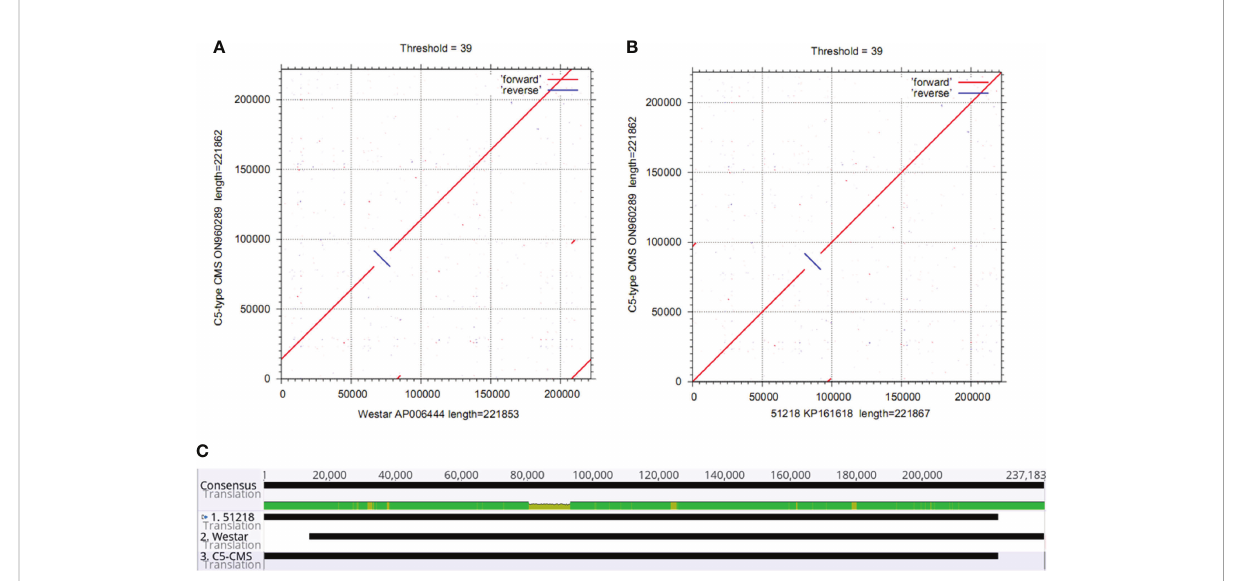
FIGURE 5 Comparative analysis of the mitochondrial genomes between the C5-type CMS line and the B . napus cultivars 51218 and Westar. (A) Dot plot alignment of the cabbage C5-type CMS and B. napus cultivar 51218 mitochondrial genomes. The comparisons show that the mitochondrial genome nucleotide sequences of B. napus cultivar 51218 (horizontal axis) resemble those of C5-type CMS cabbage (vertical axis). (B) Dot plot alignment of the C5-type CMS (vertical axis) and Westar (horizontal axis) mitochondrial genomes. The numbers indicate syntenic regions using the 51218 and Westar genome sequences as references. Comparisons showed that the mitochondrial genome sequence of the C5-type CMS line was similar to that of the B . napus cultivar 51218. (C) Pairwise alignment of mitochondrial genomes between the C5-type CMS line and B. napus cultivars 51218 and Westar was performed using Geneious Prime software. The sequence of the C5-type CMS mitochondrial genome was more homologous to that of 51218 than to that of Westar.